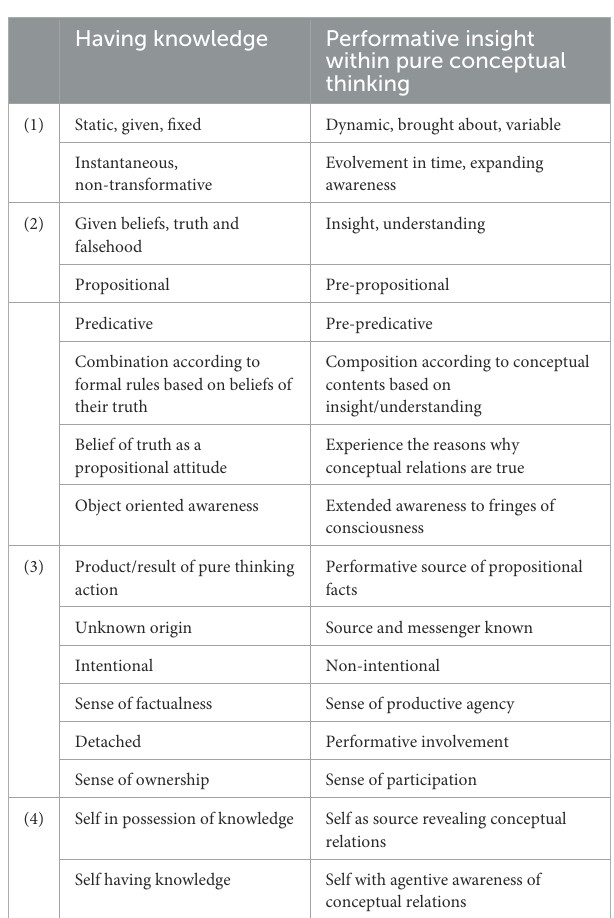
TABLE 1 Characteristics of the phenomenal contrast between having knowledge vs. performative